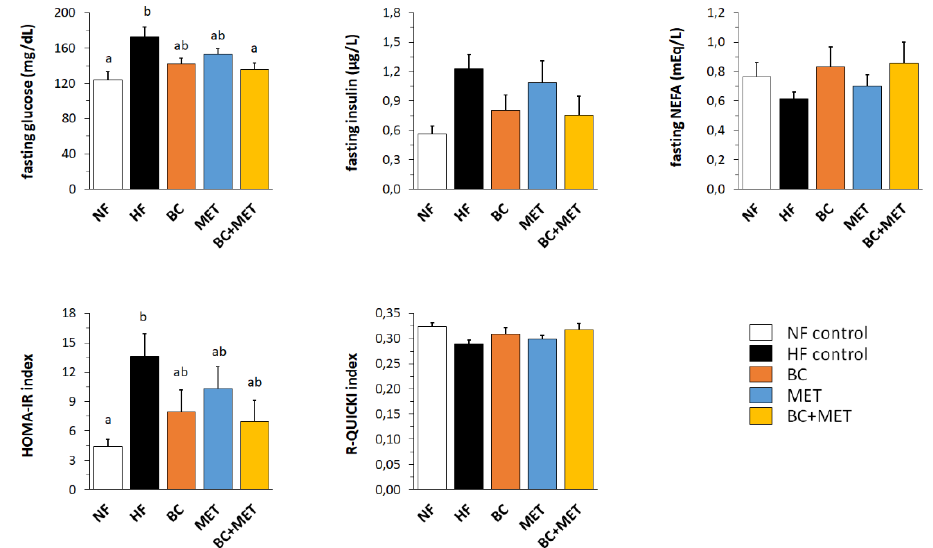
Figure 3. Blood glucose, serum insulin, serum NEFA and insulin resistance/sensitivity indexes (HOMA-IR and R-QUICKI) 5 to 7 days prior to the sacrifice and after a 6-h fast. Obesity-prone mice were challenged with a high-fat diet for 4 weeks while receiving placebo (HF control) or being treated orally with BC (3 mg/kg/day), MET (100 mg/kg/day), or their combination (BC+MET); a fifth group received placebo and was kept on a normal-fat diet (NF control). Data are means ± SEM of seven to nine animals per group. To compare between groups, one-way ANOVA followed by Tukey’s Honest Significant Difference post hoc test was used: bars not sharing a common letter (a and b) are significantly different (a ≠ b) ( p < 0.05).